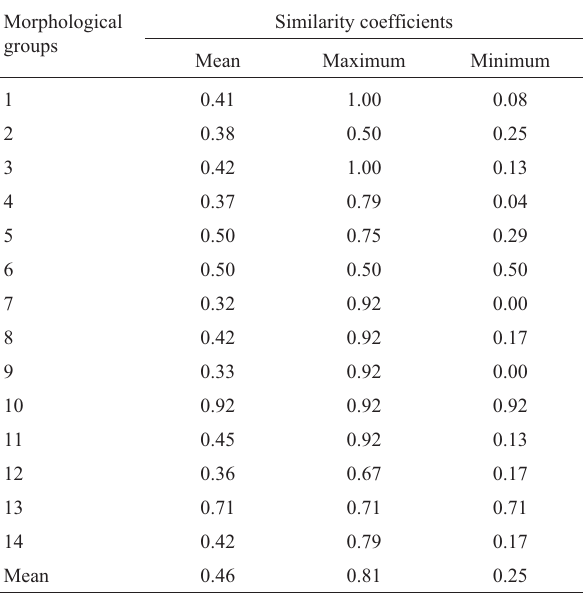
Table III - Mean, maximum and minimum similarity coefficients calcu- lated between cultivars within morphologically identical groups based on 12 SSR